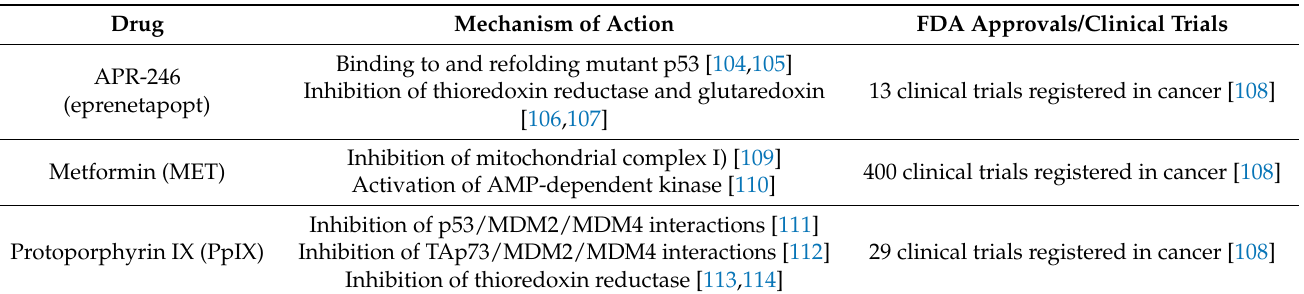
Figure 2. Reactivation of p53 protein family for improved therapy in EGFR -mutated ( EGFR mut ) lung cancer. Targeted drugs or repurposed drugs that reactivate p53 proteins in EGFR -mutated malignancies are promising candidates for improved cancer therapy. APR-246 (eprenetapopt) refolds mutant p53 to wild-type conformation and might induce lysosome-mediate degradation of mutant EGFR protein (EGFR mut ). At the same time, repurposed protoporphyrin IX (PpIX) and metformin (MET) might promote reactivation of wild-type p53 and p73 by inhibiting their interactions with MDM2 and MDMX or activating acetylation of p53 and p73 respectively. The reactivation of both tumor suppressor proteins might enhance apoptosis induction in the presence of EGFR mut . In addition, it might be foreseen that metformin-mediated inhibition of EGFR-PI3K—AKT pathway will further enhance the response of EGFR-mutated cancer cells to the treatment. Table 1. Description of drug candidates for combination treatments of EGFR mut NSCLC patients.